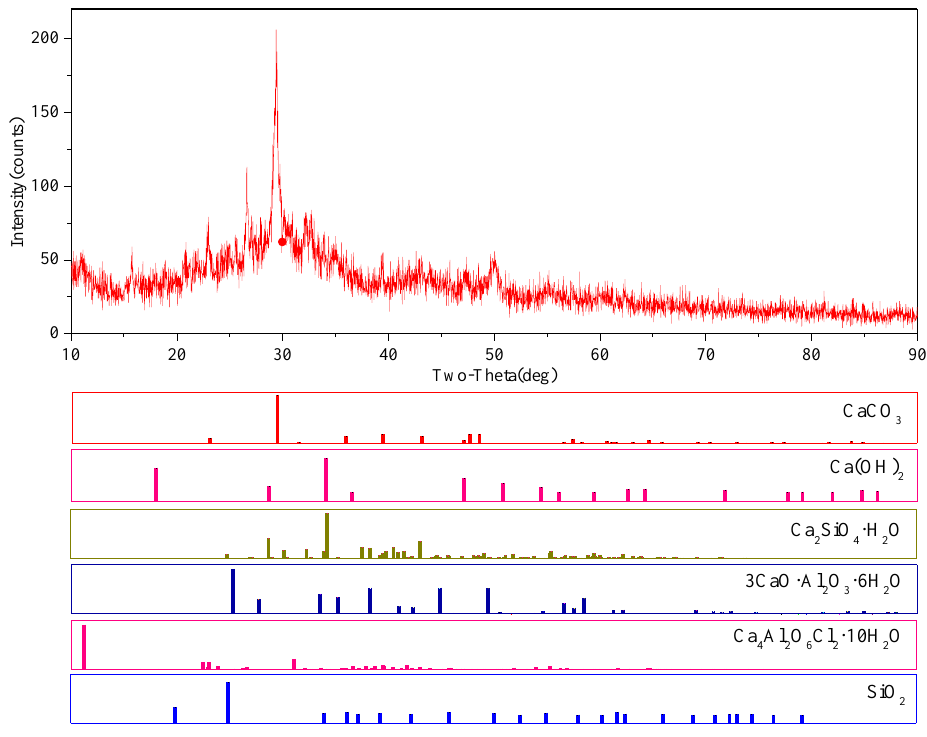
Figure 6. Diffraction pattern and main phases of paste backfill specimen submerged in an 15 g/L chloride solution for 40 days.